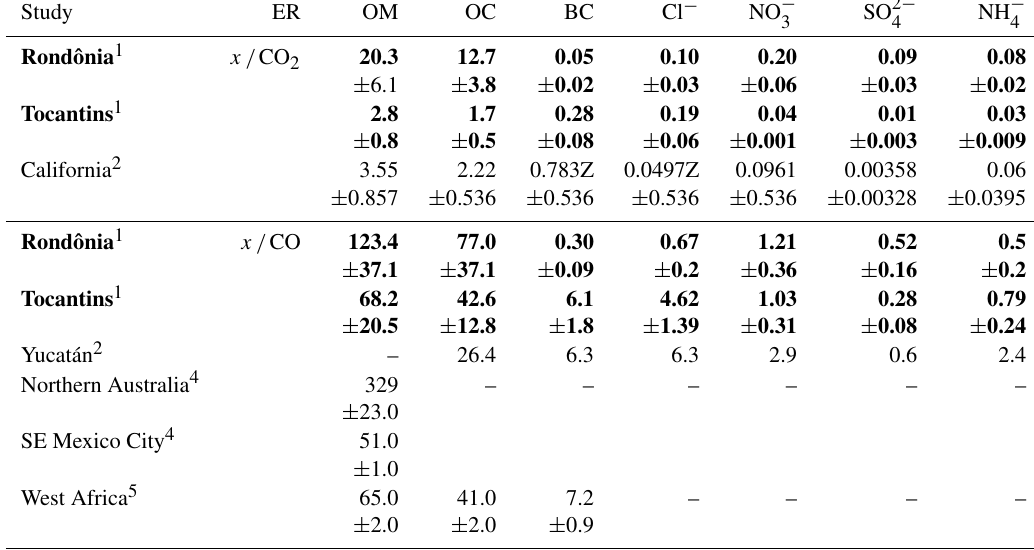
Table 5. Emission ratios and uncertainties for particulate species with respect to CO (ER x/ CO ) and CO 2 (ER x/ CO and the Tocantins fires. The ERs are presented as molar ratios and are multiplied by 1000. Calculation methods are described in Sect. 2.2.3. Also included are ERs from other studies conducted in Brazil and other locations with the specific fuel type quoted. Values in bold are from this